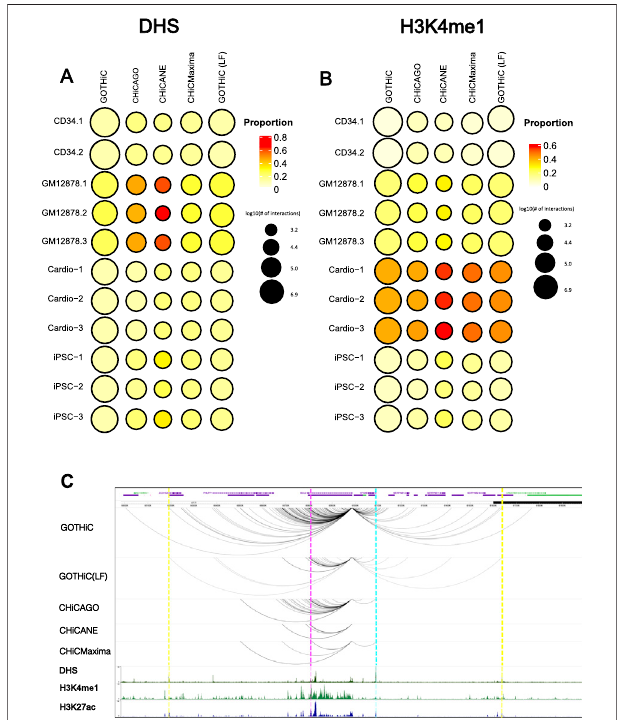
FIGURE 4 | Biologically relevant interactions. Bubble heat maps represent the proportion of interactions that overlap (A) . DHS or (B) . H3K4me1 peaks. The size of the circle represents the log10 number of promoter-other interactions identi fi ed by the different methods. (C) . A comparison between BCL2 promoter interactions in GM12878 cells within ± 1 Mb as reported by each method. Dashed lines represent examples of interactions that are identi fi ed in all tools (magenta), all tools except CHiCANE (blue), only in GOTHiC (yellow). ENCODE ChIP-seq pro fi les for DHS, H3K4me1 and H3K27ac in GM12878 cell lines are shown in the bottom tracks. DHS: DNase I Hypersensitivity